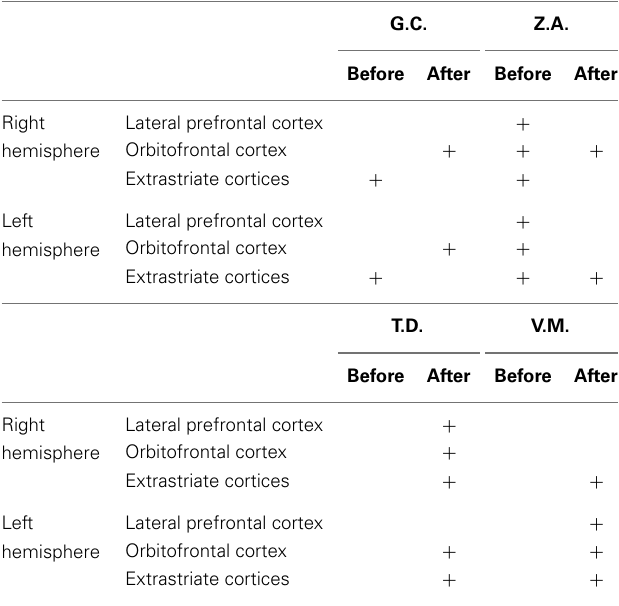
Table 3 | Main activated regions for fearful faces before and after lobectomy in right MTLE patients .